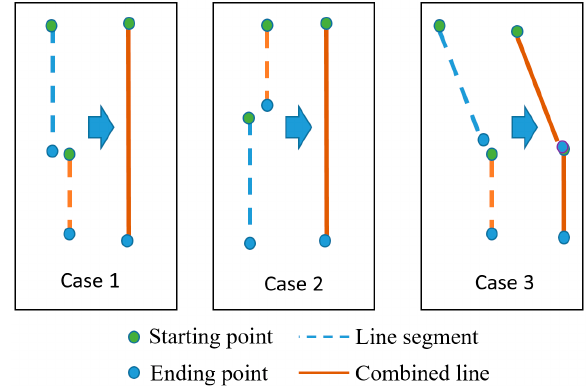
Figure 8. Angle feature used for eliminating incorrect line segments.